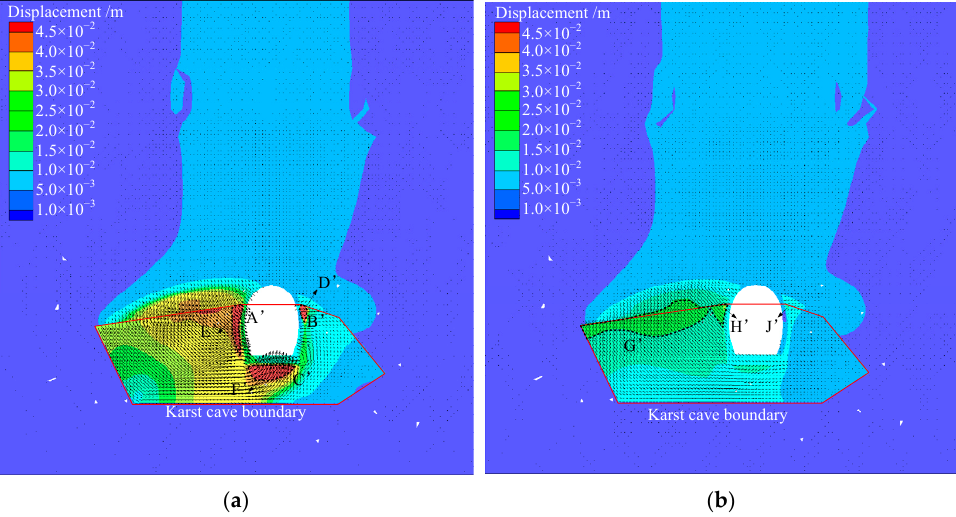
Figure 9. Displacement of surrounding rock of II-type tunnel (Y = 10 m section) ( a ) with grouting ( b ) without grouting.